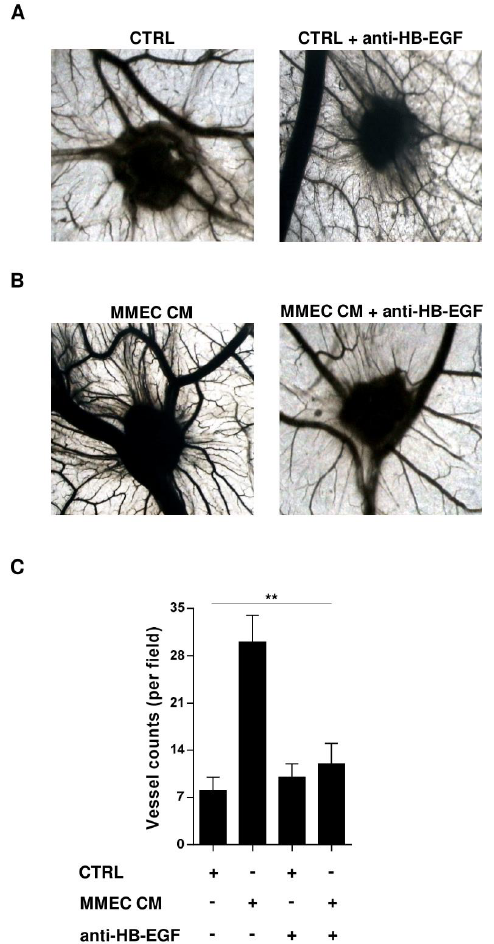
Figure 4. HB-EGF stimulates MM-associated angiogenesis in vivo. ( A , B ) Representative photographs taken in ovo of the chorioallantoic membrane assay on day 12. ( A ) Gelatin sponges soaked with serum-free medium, alone ( left , CTRL) or with 0.5 µ g / mL anti-HB-EGF antibody ( right ). ( B ) Gelatin sponges soaked with MMEC-conditioned serum-free medium (left, MMEC CM) or with MMEC-conditioned serum-free medium containing 0.5 µ g / mL HB-EGF antibody (right). Original magnification 50 × . ( C ) Quantification of newly formed vessels. Results are mean and SD of three technical replicates. ** p < 0.01, Mann – Whitney U test .